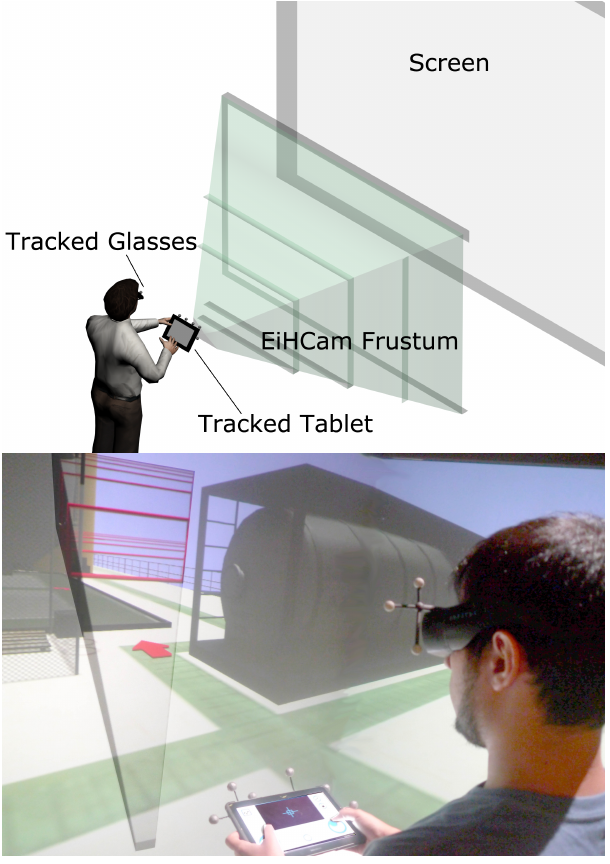
Figure 10. The frustrum drawn on screen based on the tablet’s position.